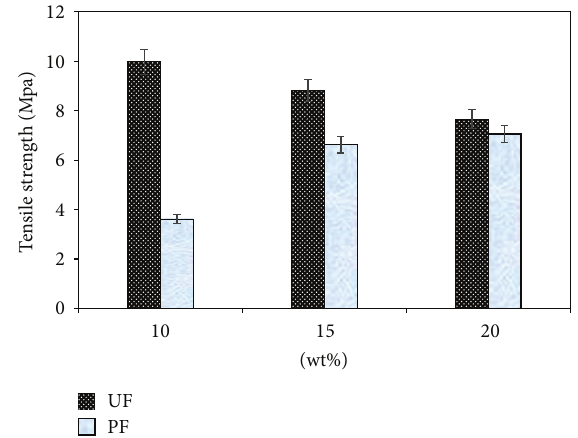
Figure 6: Tensile strength of sago particleboard versus resin matrix content